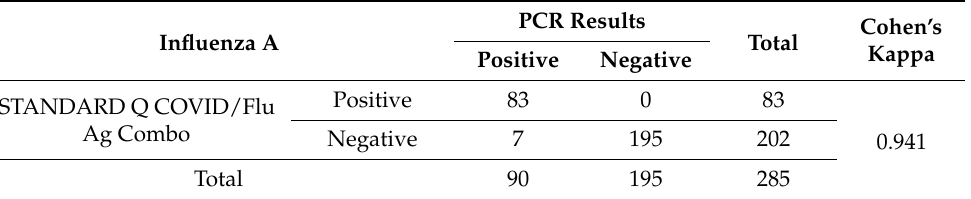
Table 2. Diagnostic performance of the STANDARD Q COVID/FLU Ag Combo compared to the real-time PCR for detection of influenza A.